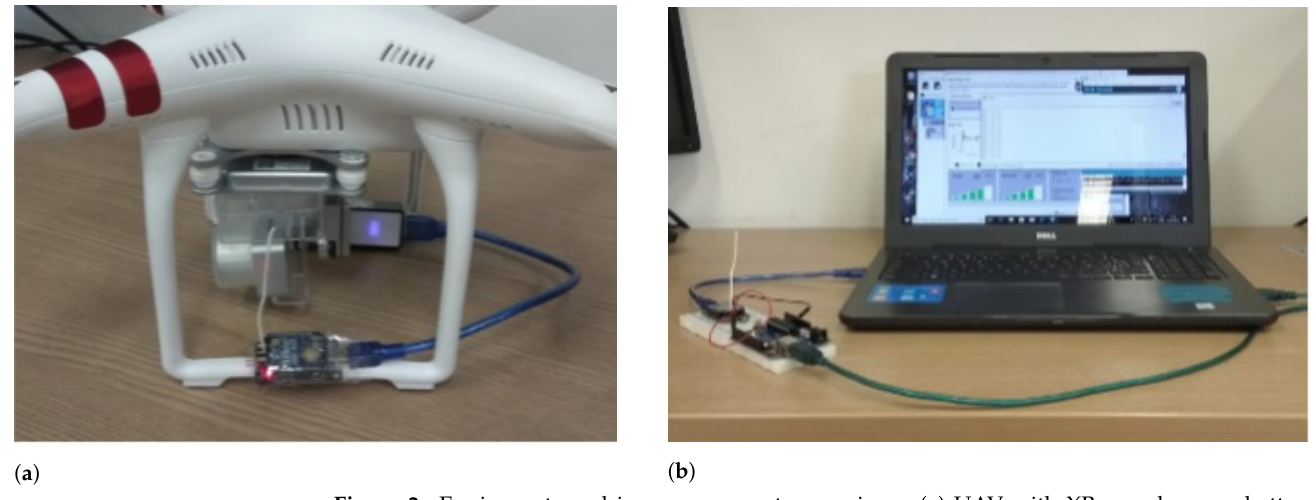
Figure 2. Equipment used in measurement campaigns. ( a ) UAV with XBee and power battery modules. ( b ) Base station for collecting measurement